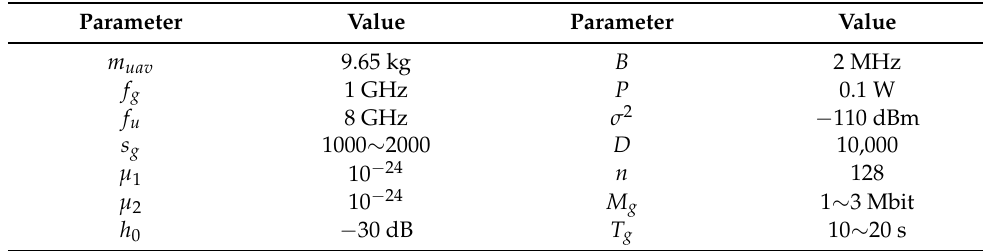
Table 2. Simulation